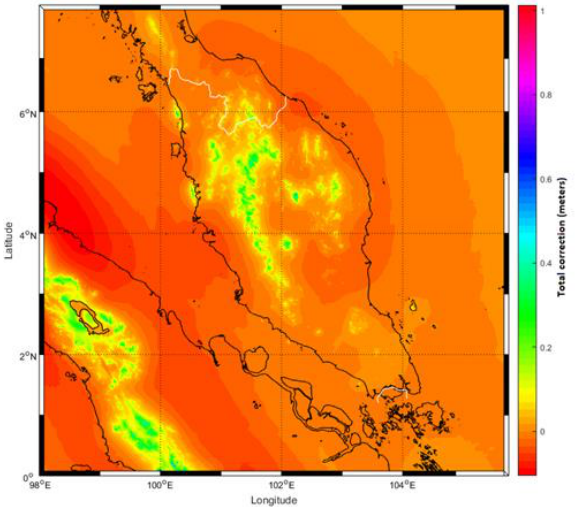
Figure 8 Total additive corrections (Unit: